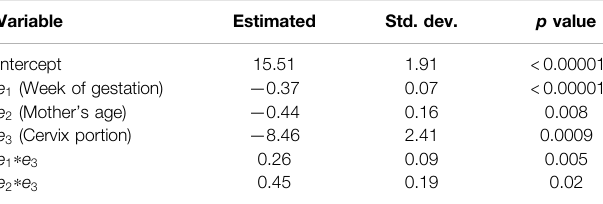
TABLE 4 | Estimated coef fi cients, standard deviations, and p values for statistical signi fi cance of the linear mixed effects model for S in the in vivo NHP pregnant